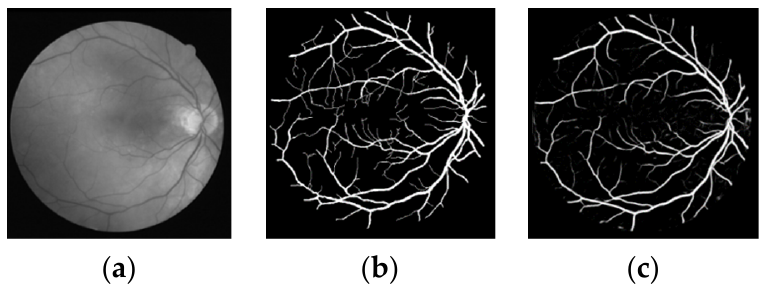
Figure 6. First group of segmentation results ( a ) original image ( b ) gold standard image ( c ) segmen- tation results of this paper.